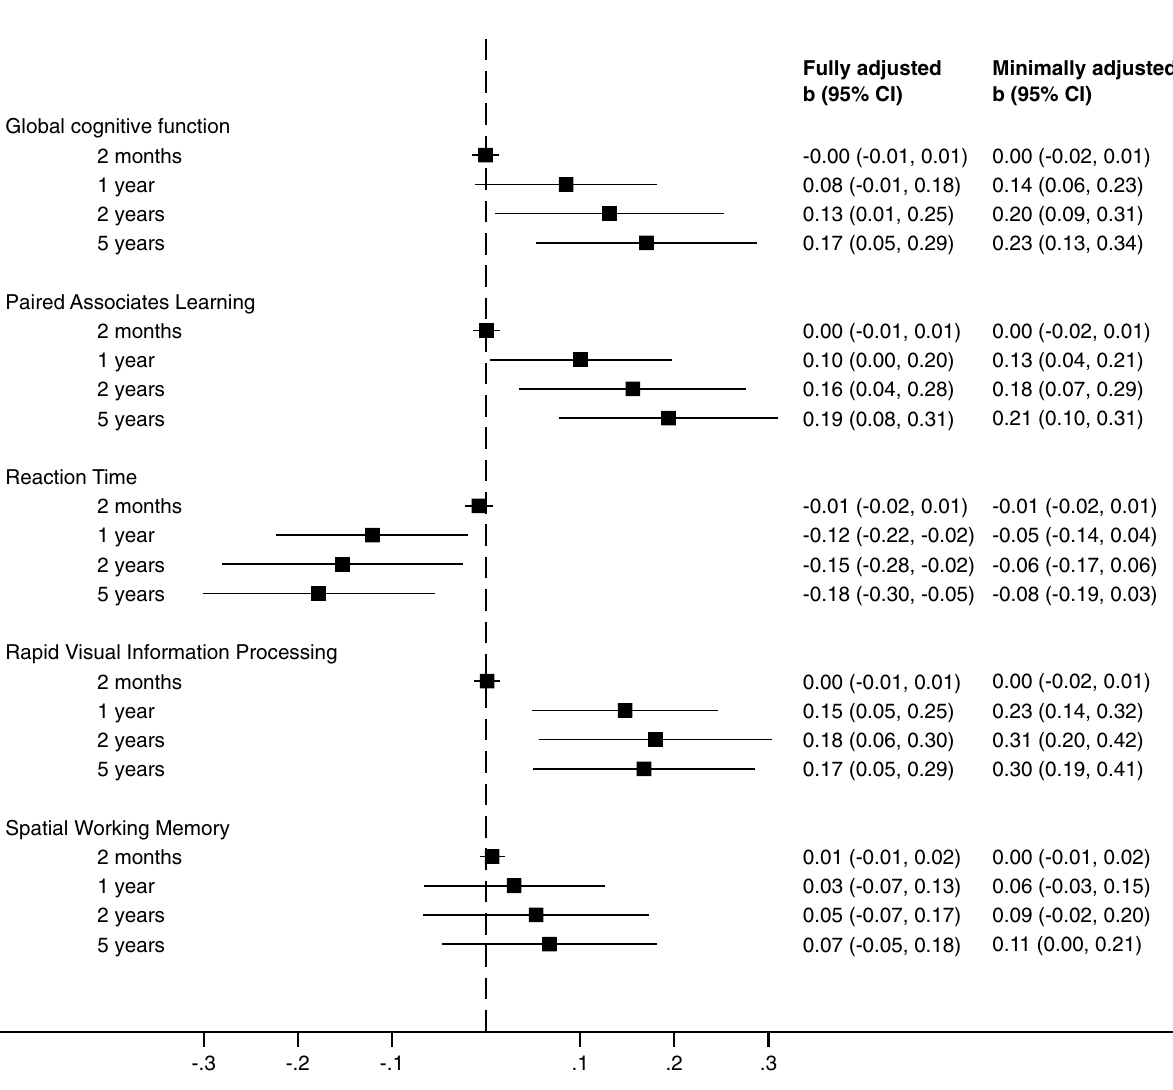
Figure 1. Associations of long-term sunlight exposure with cognitive function in the Cardiovascular Risk in Young Finns Study Abbreviations: CI, confidence interval. Estimates are differences in the rank-order normalized cognitive function scores per 1 MJ/m 2 difference in the average daily exposure to global solar radiation in residential neighborhood from linear regression